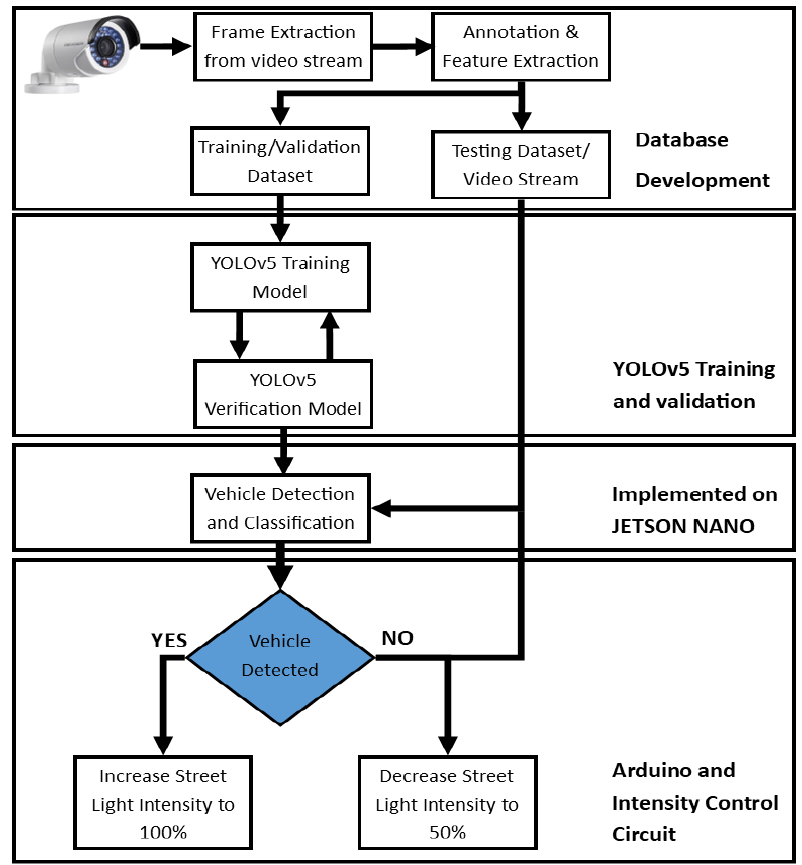
Figure 1. Software structure of the proposed